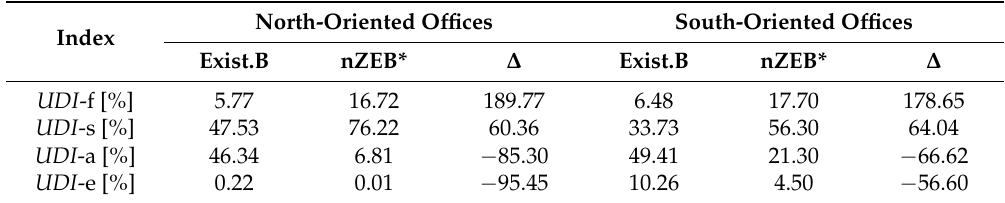
Table 7. Results of the daylight provision analysis for the existing building and the nZEB* building.